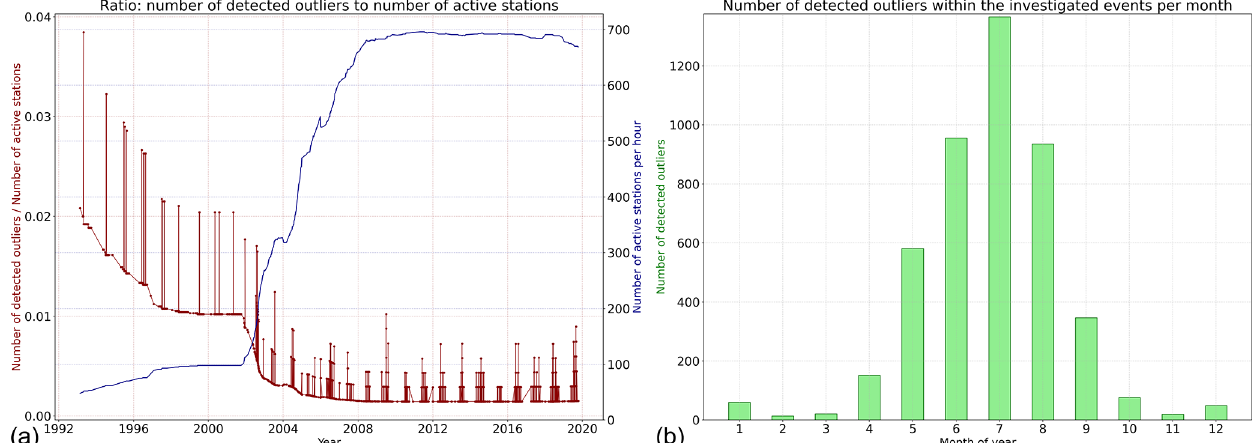
Figure A1. Panel (a) shows the number of hours with outliers within the investigated hourly events (aggregated from 1min) of all stations per year. Panel (b) shows the number of detected outliers within the investigated events for every month within the hourly data using a CR value of